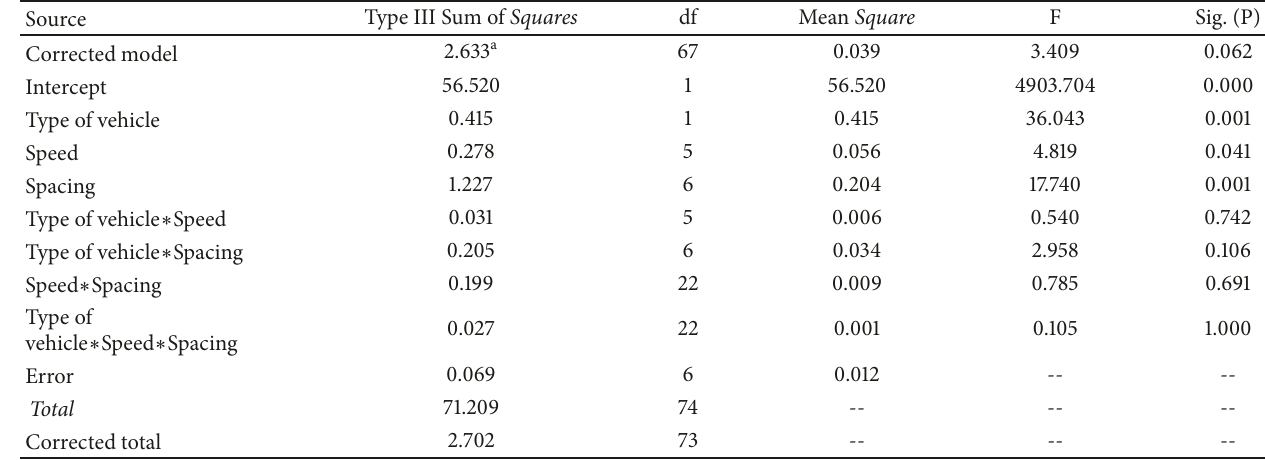
Table 5: Interaction test. The dependent variable: the combined total weighted acceleration RMS.